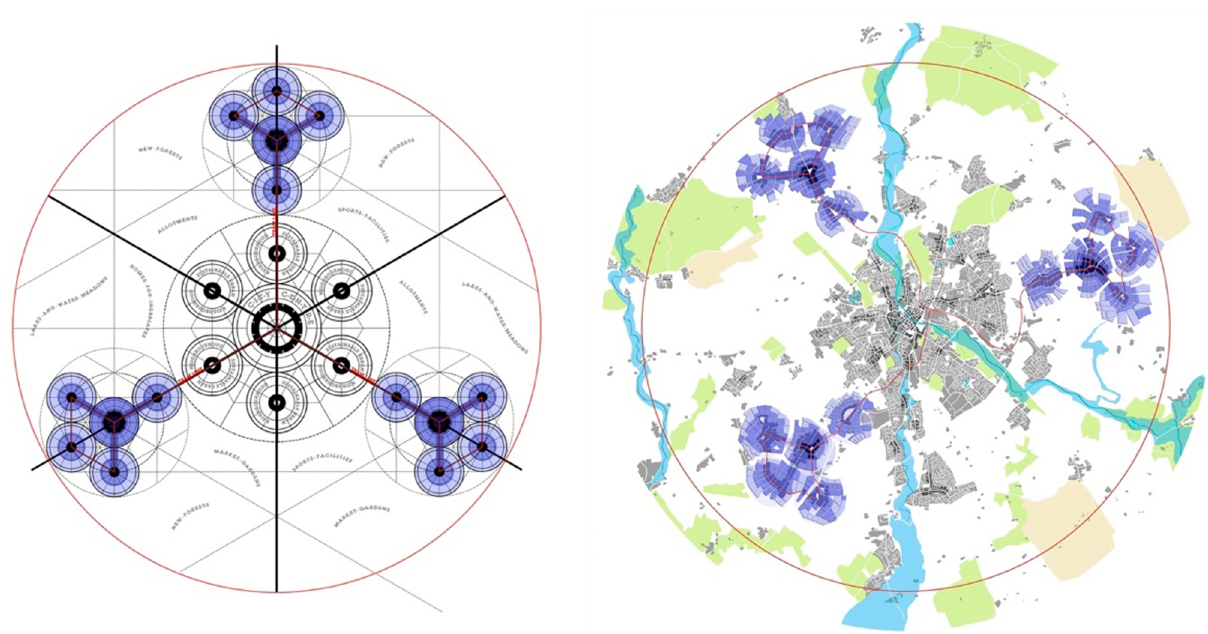
Figure 3. The Snowflake’s diagram and its application on the periphery of the fictitious town of Uxcester. Source: Rudlin & Falk